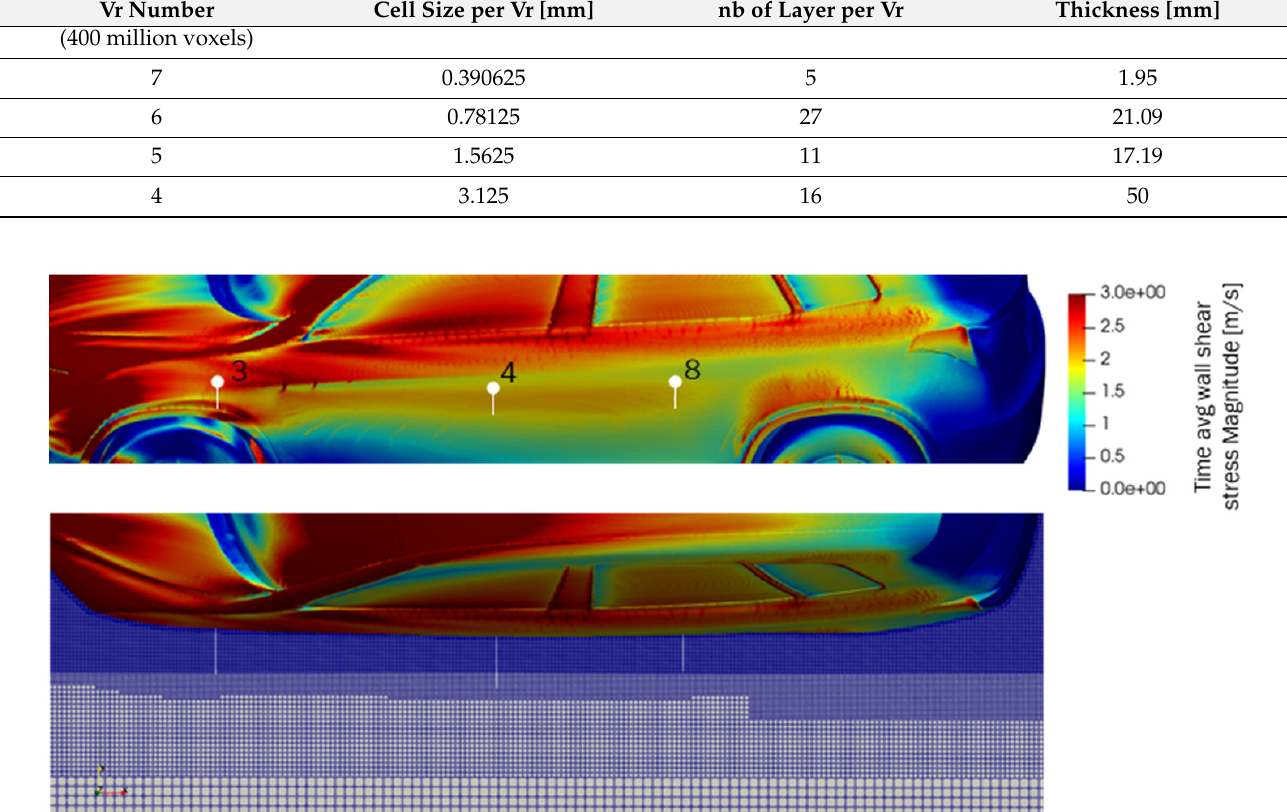
friction velocity values ( top view ) are used to compute non-dimensional velocity profiles.